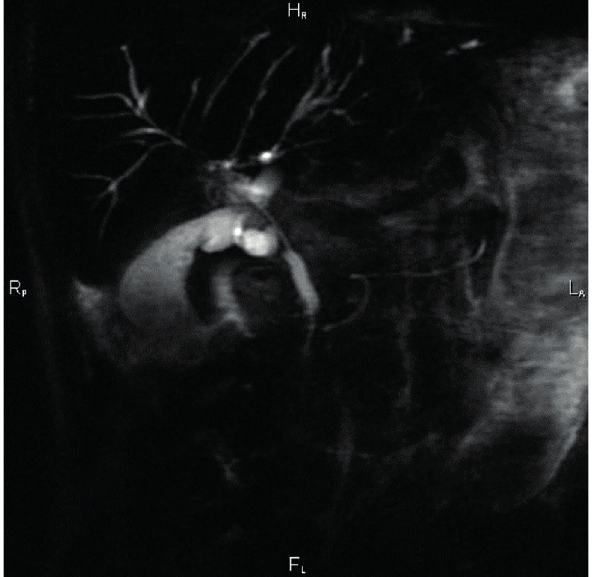
Fig. 4. MRCP with maghemite bowel preparation: 37-year-old man with primary biliary cirrhosis before liver transplantation, presence of advanced ascites. Good delineation of intra- and extrahepatic biliary ducts with multiple stenoses and dilatations and visibility of main pancreatic duct is documented after SPIO per-oral